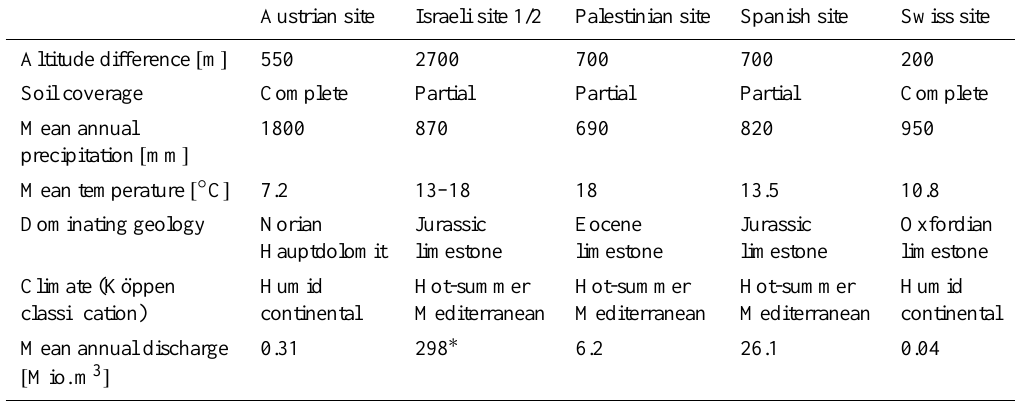
Table 1. General characteristics of the study